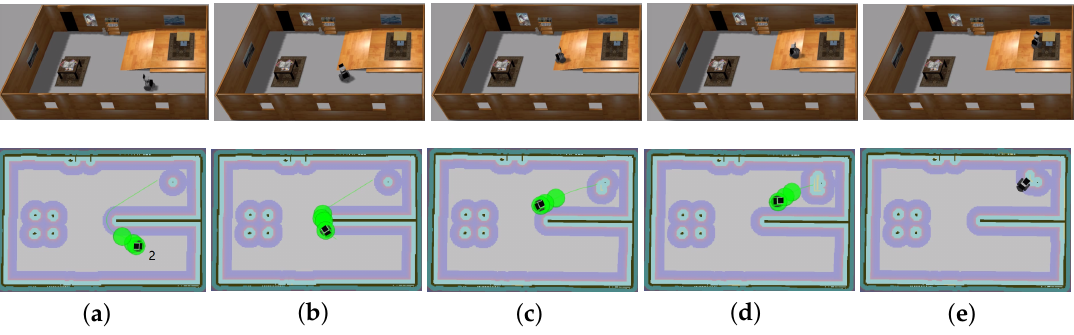
Figure 9. Simulation experiment of Task 2. The start location is indicated in ( a ). The robot is making a turn to approach the slope in ( b , c ). The robot climbs the slope in ( d ) and reaches the target above the ground in ( e ).